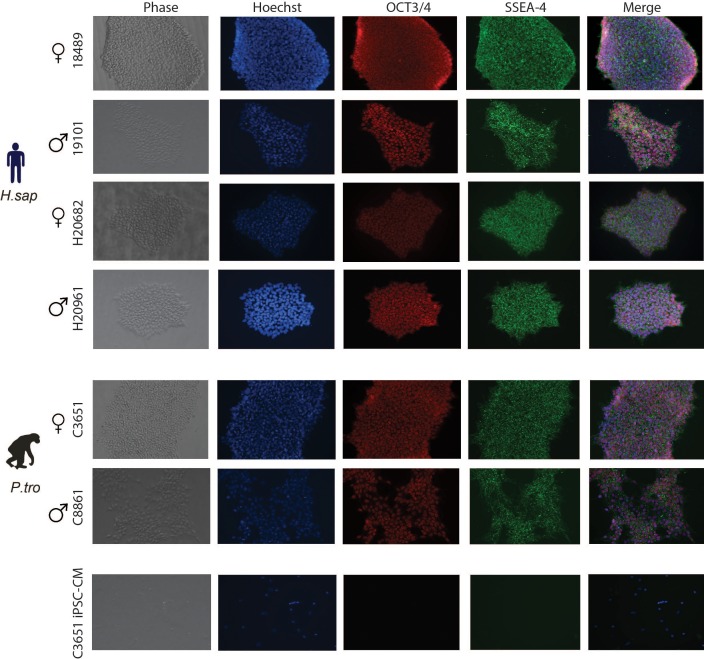
Human and chimpanzee iPSCs express key pluripotency factors.Immunocytochemistry for nuclear OCT3/4 and cytoplasmic SSEA-4 in a subset of iPSCs from male and female human and chimpanzee individuals. Nuclei are stained with Hoechst. iPSC-derived cardiomyocytes (iPSC-CM) are shown as a negative control.